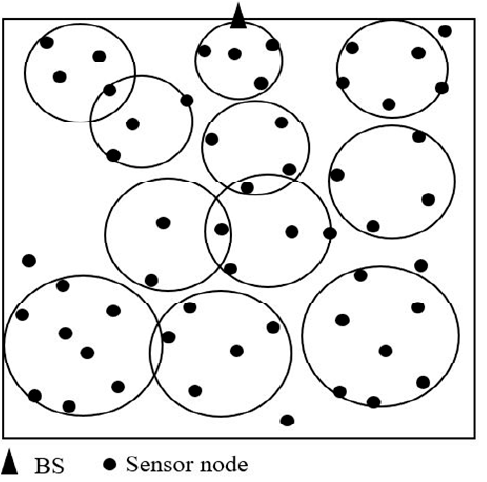
Figure 6. Schematic diagram of the distribution of circular areas.